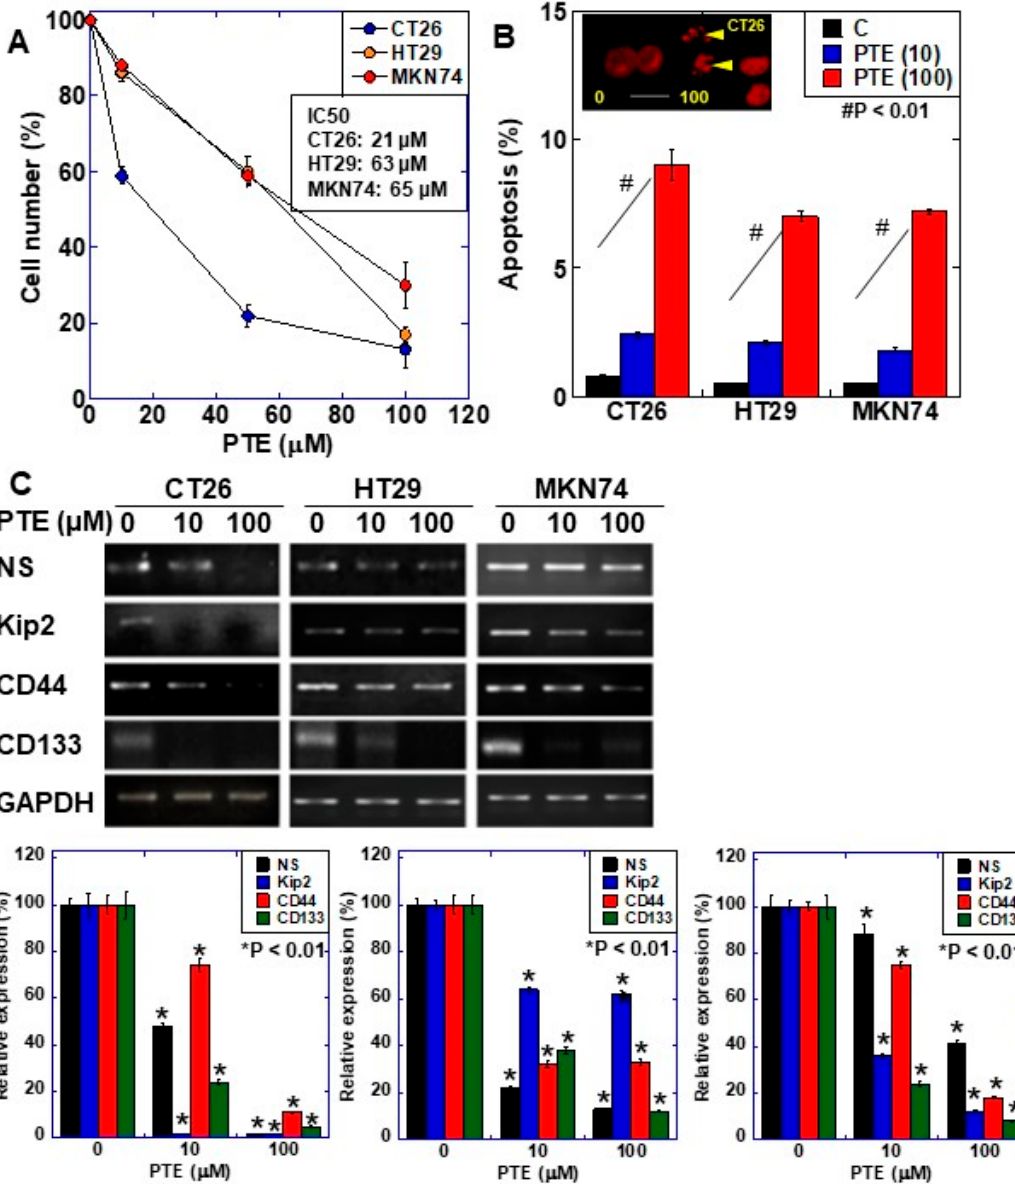
Figure 1. Effect of pterostilbene (PTE) on cell proliferation and expression of stem cell markers in cancer cell lines. ( A ) Cell proliferation was assessed by 3-(4,5-dimethylthiazol-2-yl)-5-(3-carboxymethoxyphenyl)-2-(4-sulfophenyl)-2H-tetrazolium, inner salt (MTS) assay. Cells were treated with PTE for 48 h. ( B ) Apoptosis was assessed by ethidium bromide (EtBr) staining. Insert, CT26 cells treated with PTE for 48 h were stained with EtBr. Arrow head, apoptosis body. Scale bar, 20 µ M. ( C ) mRNA expression of stem cell markers; nucleostemin (NS), CD44, Kip2, and CD133 were examined by RT-PCR. Glyceraldehyde 3-phosphate dehydrogenase (GAPDH) was amplified for loading standard. Lower panels were semi-quantification of stem cell marker expression examined by RT-PCR. Error bar, standard deviation from three independent examinations. Statistical difference was calculated by ordinary analysis of variance. * Statistical difference from PTE (0 μ M). PTE, pterostilbene; IC50, 50% inhibitory concentration.